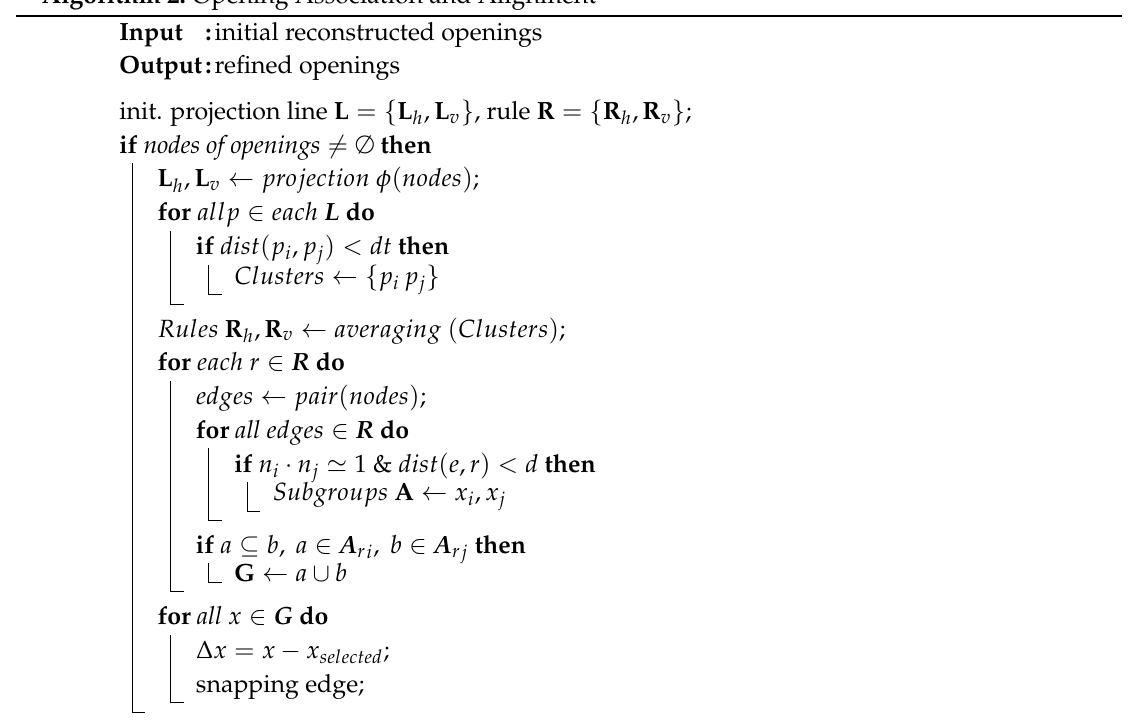
Algorithm 2: Opening Association and